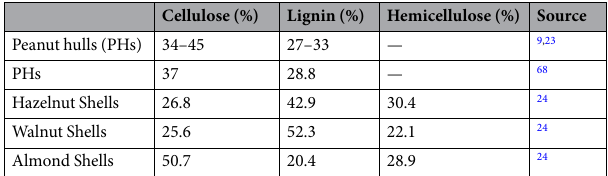
Table 1. Cellulosic and lignin content in different nut